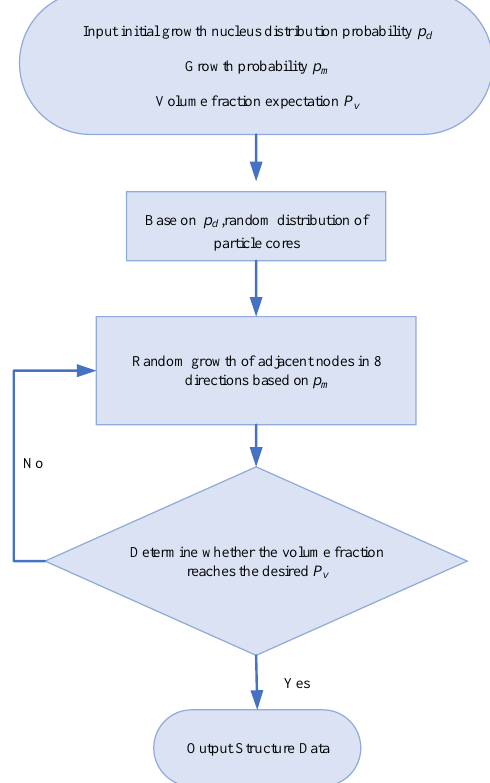
Figure 2. The flow chart of C-S-H nucleation growth.